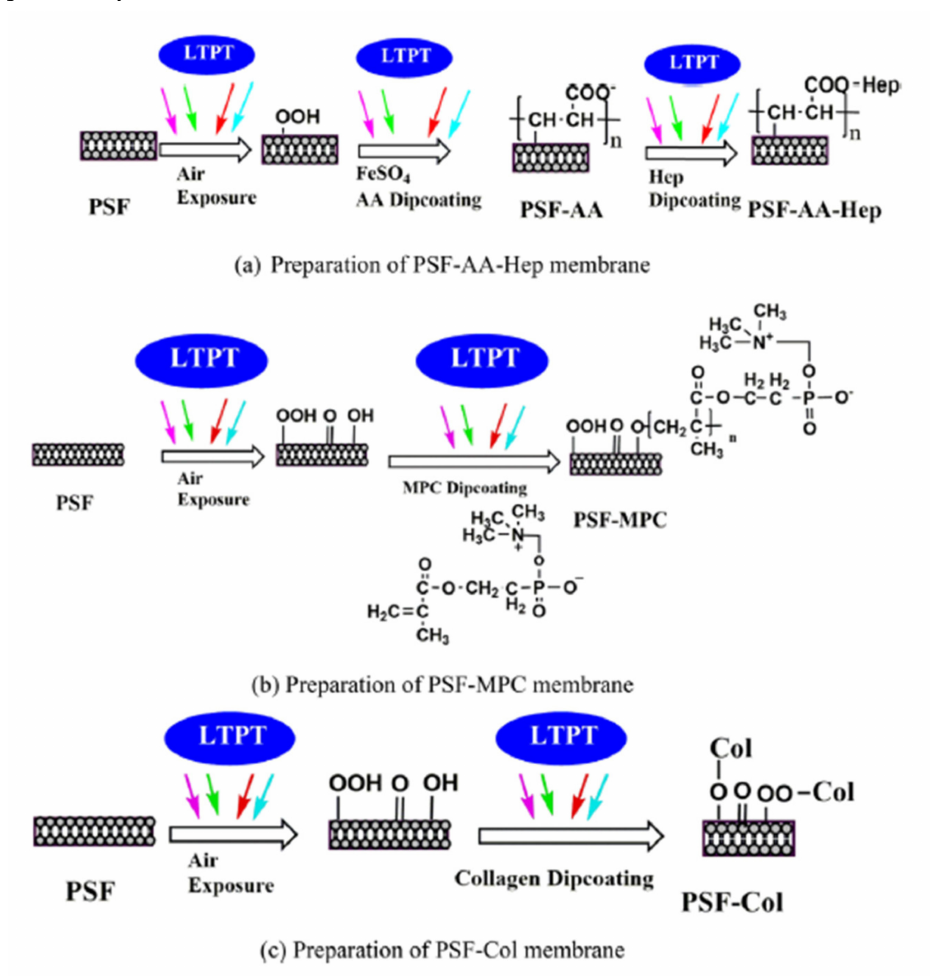
Figure 9. Modification process of surface grafting (reproduced with permission after